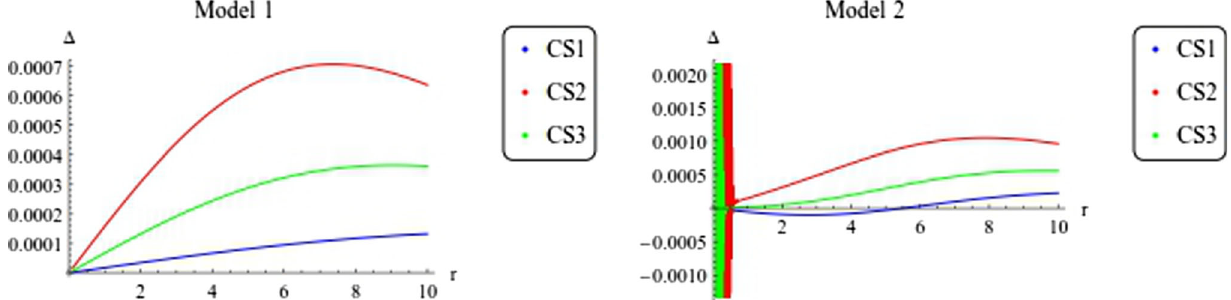
Fig. 13 Change in (cid:22) versus